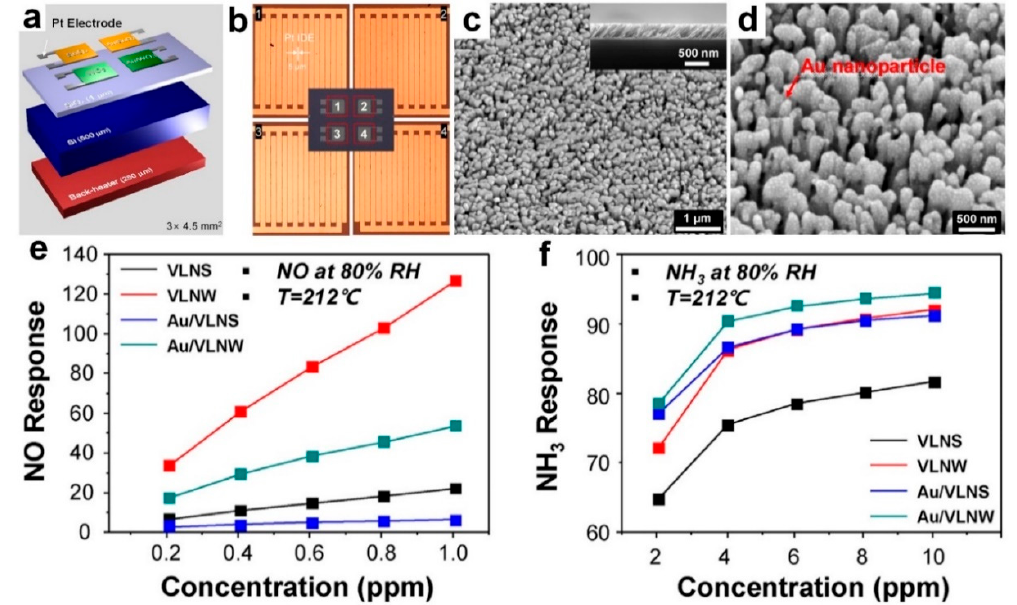
Figure 12. ( a ) Schematic diagrams of chemi-resistive electronic nose (CEN) with micro-heater on the back-side). ( b ) Optical images of four Pt interdigitated electrodes (IDEs) with spacing and width of 5 and 40 m, respectively. ( c , d ) Top-view and cross-sectional FE-SEM images (inset) of VLNs of WO 3 (VLNW) and Au-functionalized VLNW (Au/VLNW). Sensing response of each channel in the CEN as a function of ( e ) NO and ( f ) NH 3 concentration at 212 °C in 80% RH condition [68].